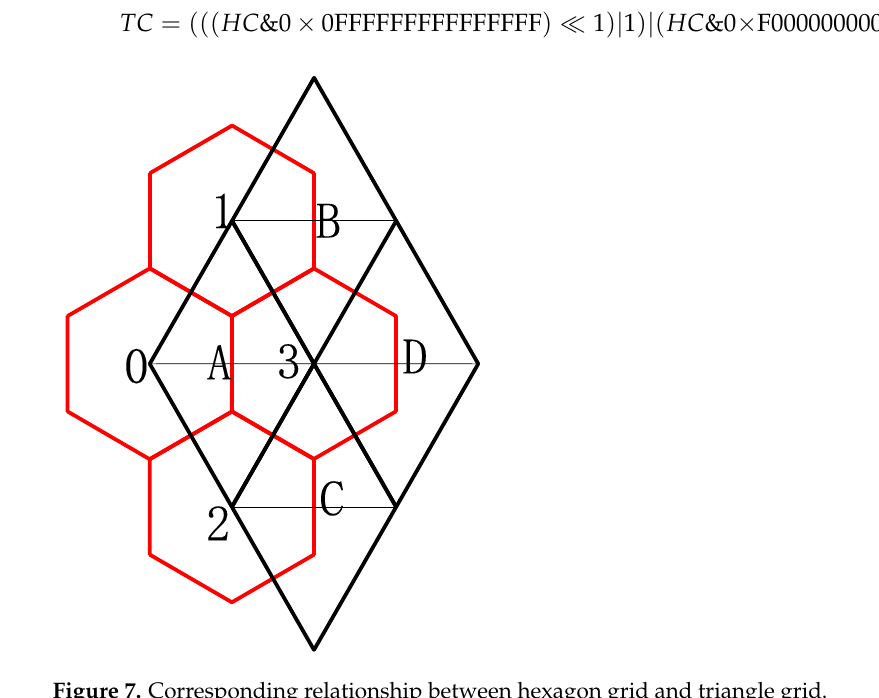
Figure 7. Corresponding relationship between hexagon grid and triangle grid. The HtoTcode rule of spatial discrete line and surface data involves the transformation problem of the boundary and the vertex hexagonal cell of the basic diamond. According to the position of the hexagonal grid cell on the basic diamond, the hexagonal cells are divided into the following 4 categories and 11 subcategories (as shown in Figure 8): A is the cell in the basic diamond area, and its six adjacent cells are all in a basic diamond; B 1 , B 2 , B 3 and B 4 are the basic diamond boundary cells; C 1 , C 2 and C 3 are the basic diamond corner cells; E 1 , E 2 and E 3 are the vertex cells of icosahedron, which need to be cut into a pentagon. Among them, E 1 and E 2 are different from the basic diamond to which other cell types belong. The basic diamond of E 1 is the virtual basic diamond 0, and the basic diamond of E 2 is the virtual basic diamond 11. In addition, the adjacency relations of the applied cells during the transformation ensure the continuity of spatial discrete lines and